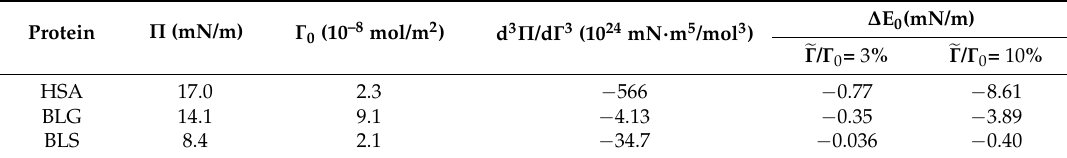
Table 2. Values of the derivatives d 3 /dΓ 3 in the minimum and the corresponding corrections to the visco-elasticity modulus E 0